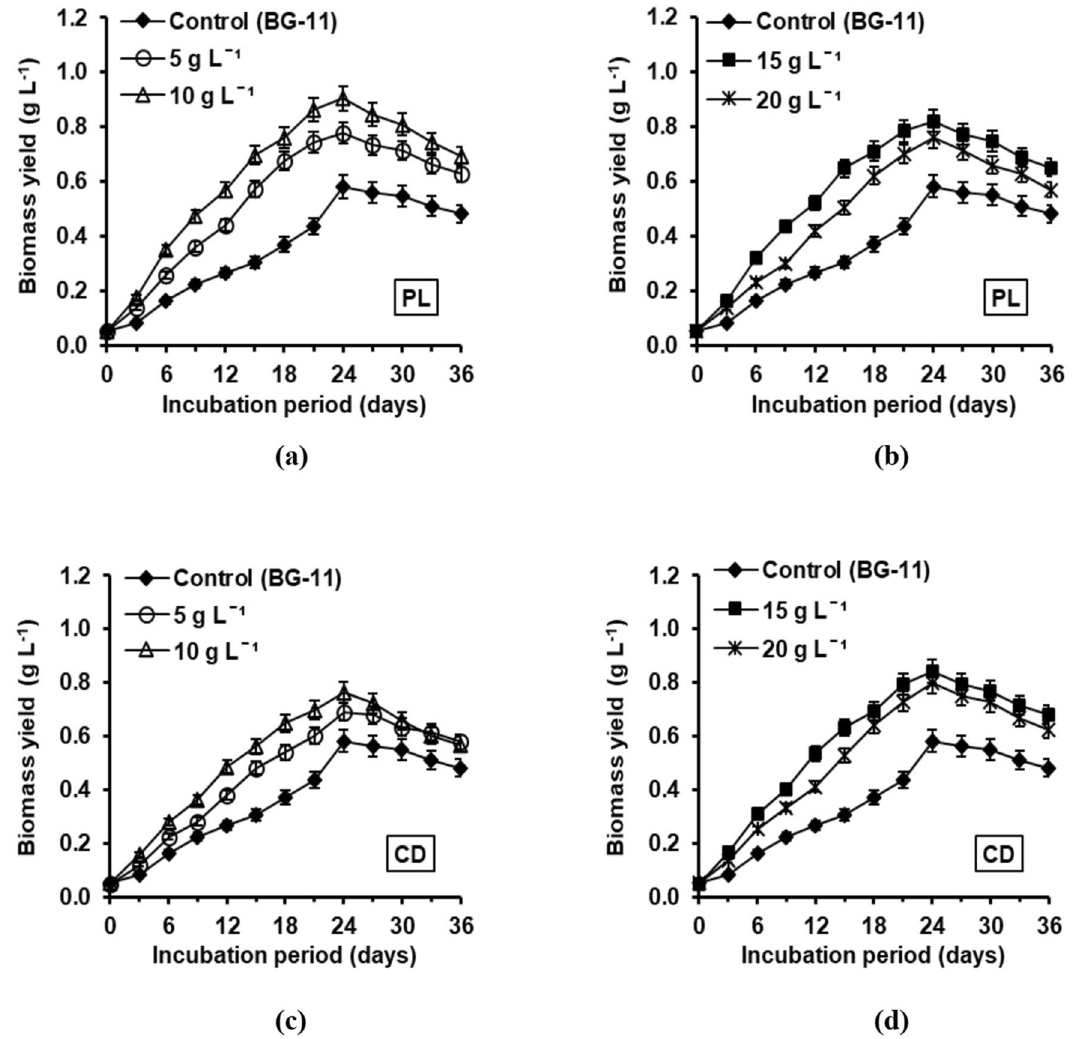
Figure 3. Time-course analysis of biomass yield (g L −1 ) of A. variabilis cultivated in different concentrations of PL: ( a ) 5 g L −1 , 10 g L −1 ( b ) 15 g L −1 , 20 g L −1 and CD: ( c ) 5 g L −1 , 10 g L −1 ( d ) 15 g L −1 , 20 g L −1 compared to control BG-11 medium.